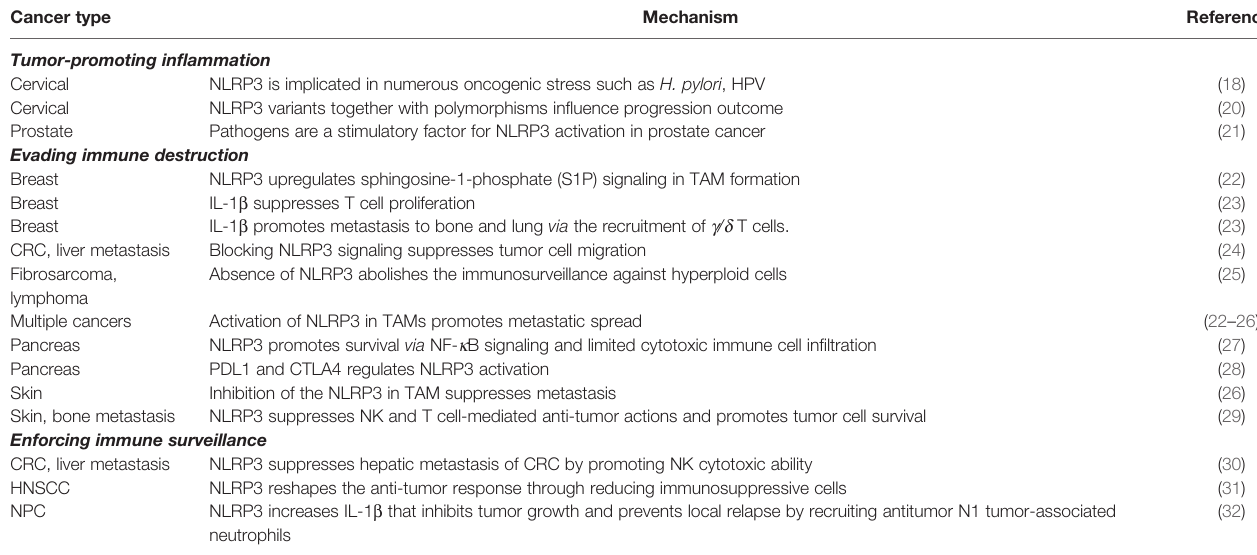
TABLE 1 | In fl ammation-associated cancer